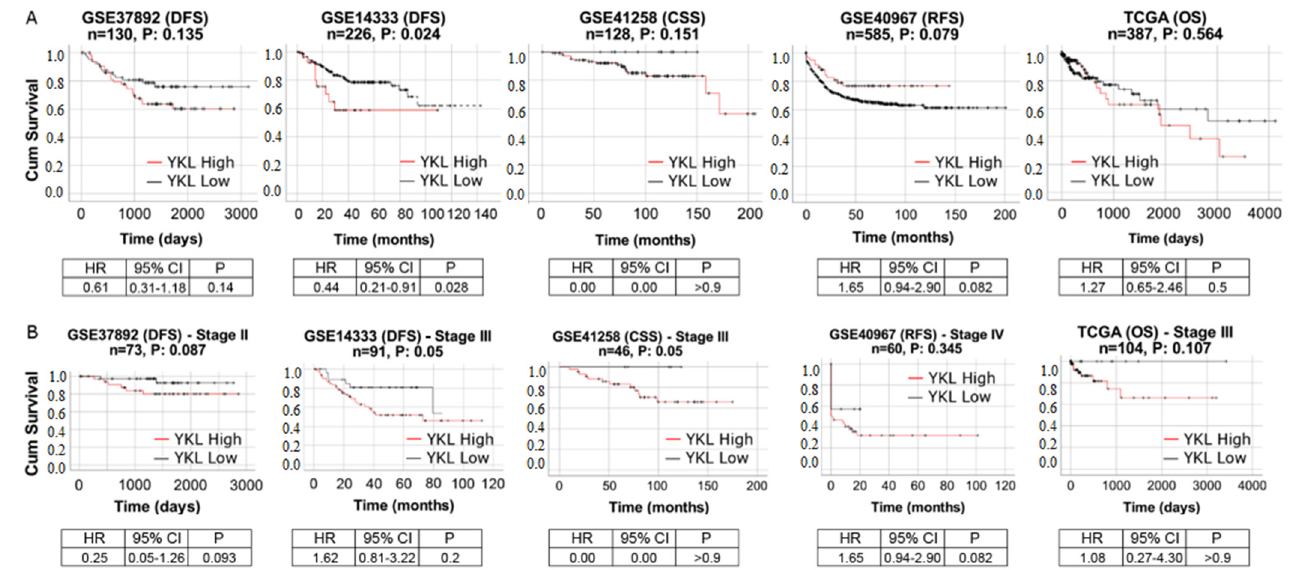
Figure 6. Kaplan–Meier survival curves of high YKL-40 (dashed line) versus low YKL-40 (solid line) for ( A ) all patients of cohorts 1–4 and cohort 6 and for ( B ) patients with advanced CRC stages from the same cohorts. Expression value thresholds for determining high and low groups were determined through maxstat R package, except for the analysis of all patients of TCGA, where it was determined with YKL-40 median expression threshold. p -values were calculated using log-rank tests. Tick marks represent censored data.